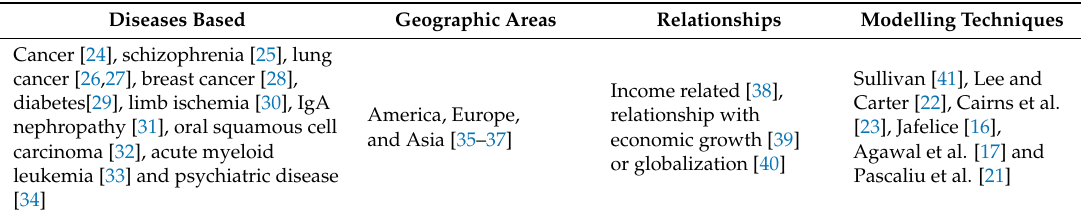
Table 1. Summary of Reviewed Life Expectancy (LE) Predictions.